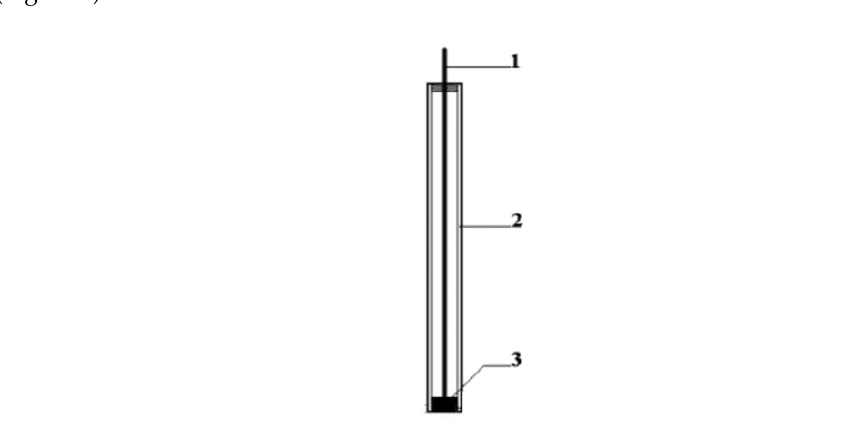
Figure 1. Cylindrical Teflon electrode (biosensor): (1) electric connection (copper wire); (2) Teflon lining; (3) carbon paste.